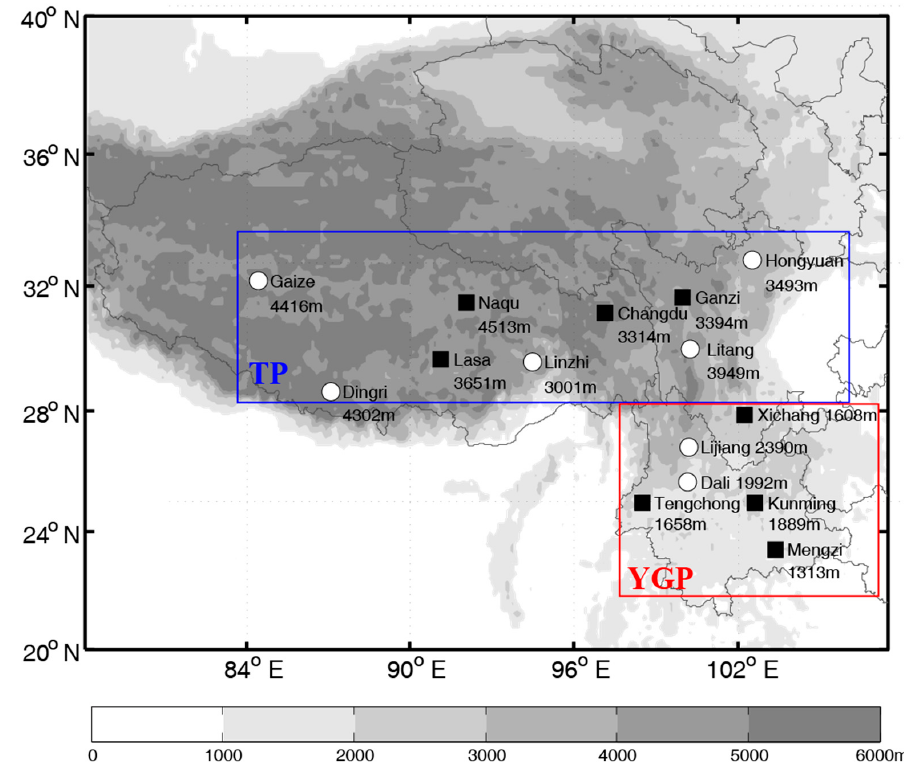
Figure 1. Locations of the independent radiosonde sites over the Tibetan Plateau (TP, blue box) and the Yunnan-Guizhou Plateau (YGP, red box) during the 2008 China-Japan Meteorological Disaster Reduction Cooperation Research Center Project (JICA)/Tibet Project intensive observing period (IOP). Gray shading represents topography. The black squares denote the routine sounding stations, and the white circles denote the added stations.